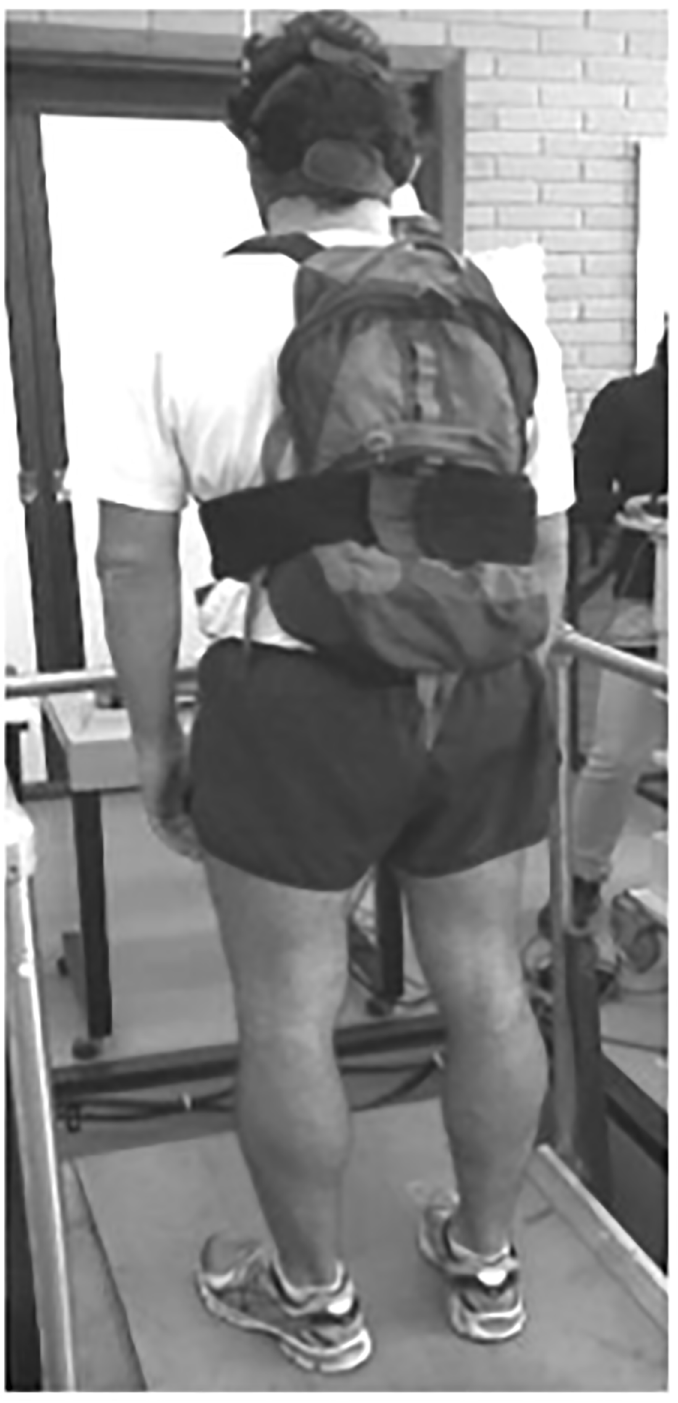
Fig 1. The athlete and his backpack with the extra